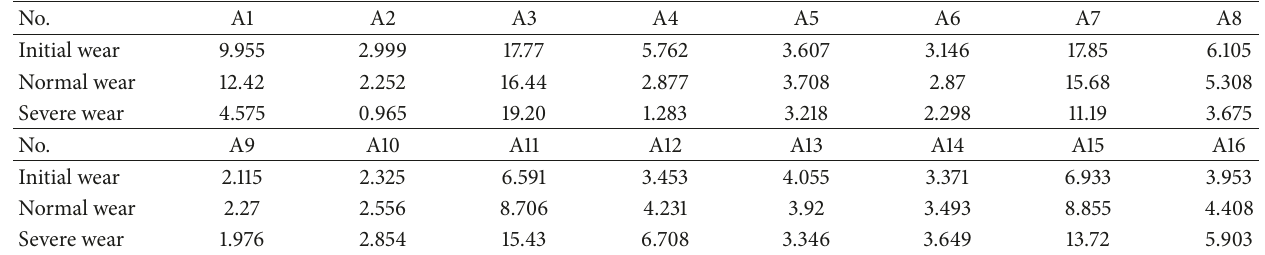
Table 5: Energy proportion ( × 10 2 ) of the vibration signal in each frequency band after wavelet packet decompositions. No.